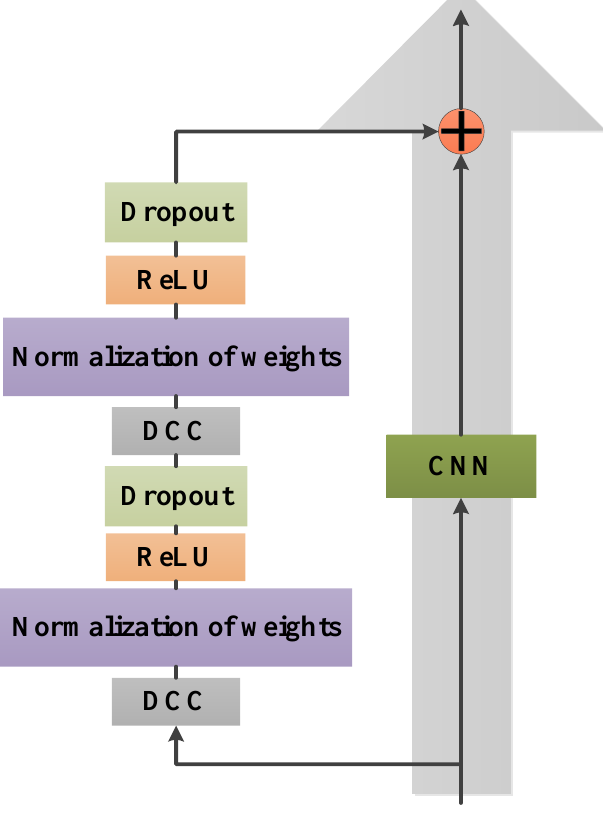
Figure 3. TCN residual block structure.